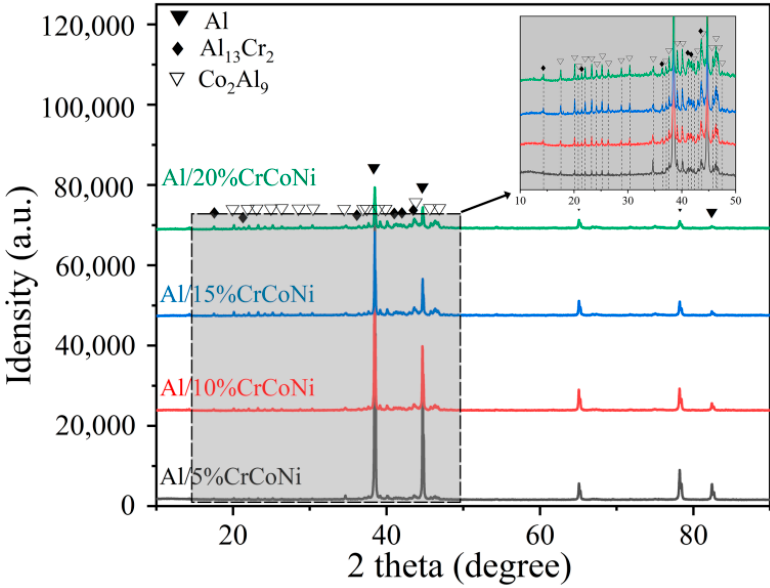
Figure 3. XRD pattern of the CrCoNi MEA reinforced Al matrix composites.